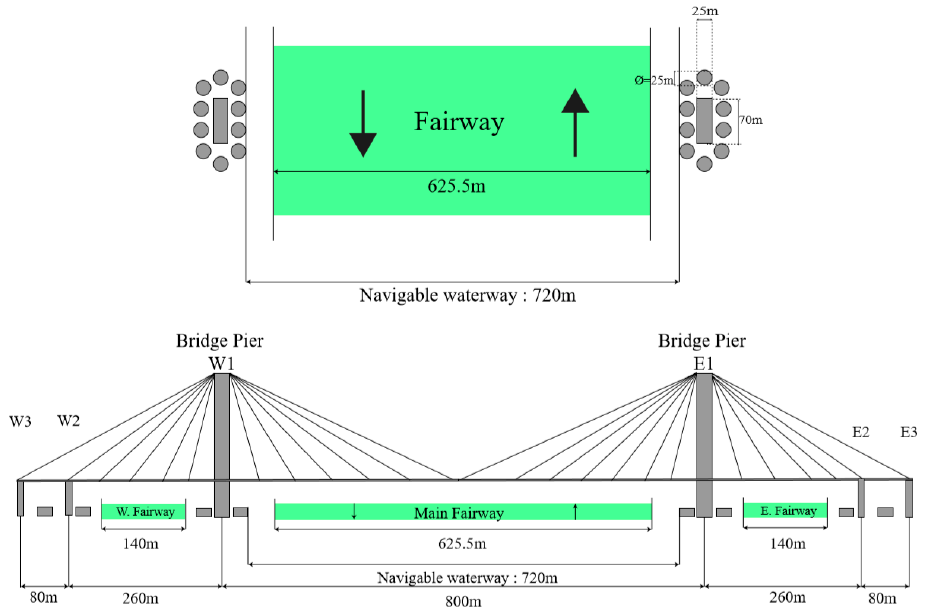
Figure 6. Cable-stayed part of Incheon bridge.